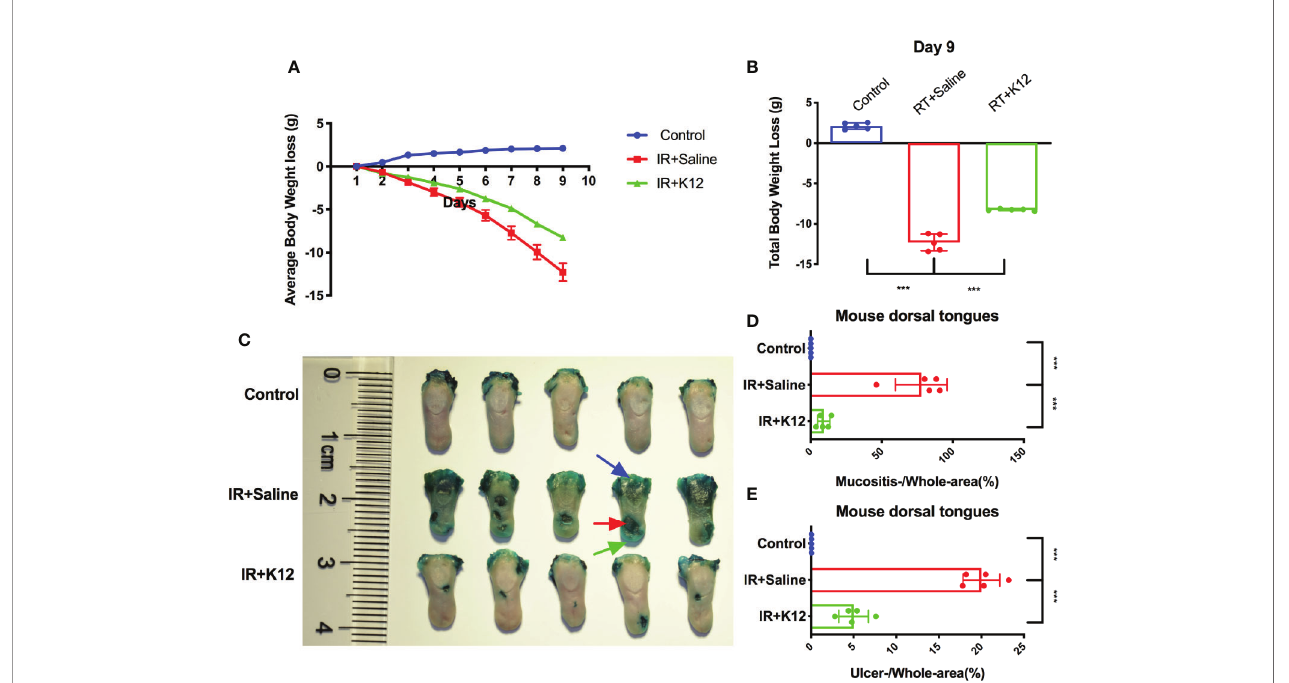
FIGURE 1 | Streptococcus salivarius K12 alleviates body weight loss and reduces tongue ulcer area in RIOM mice. (A) Average body weight loss. (B) Total body weight loss. (C) Toluidine blue staining of harvested tongues. The area of mucositis with (red arrow) and without ulcer (green arrow) was stained blue. Blue arrow: staining at the site of incision to remove tongue. (D) Quantitative analyses of mucositis area (mucositis+ulcer/whole surface area). (E) Quantitative analyses of ulcer area (ulcer/whole surface area). Data are presented as mean ± SD. *** P < 0.001. N = 5 per